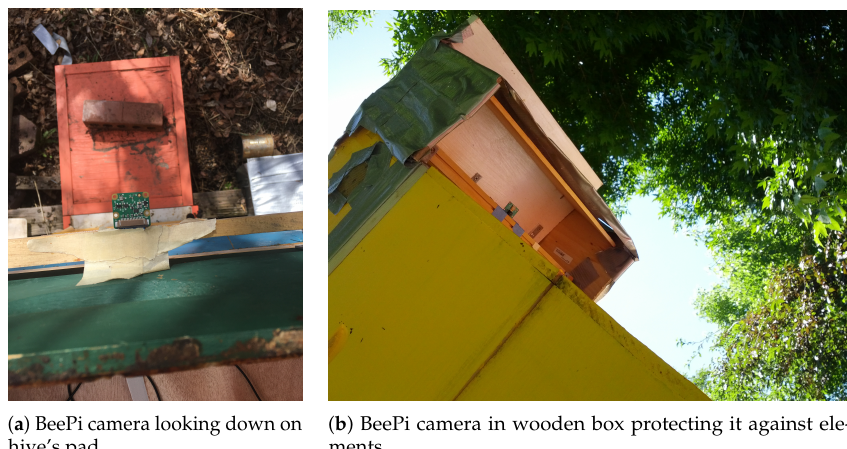
Figure 5. BeePi monitor’s camera looks down on hive’s landing pad ( a ) and is protected along five sides against elements with custom wooden box ( b